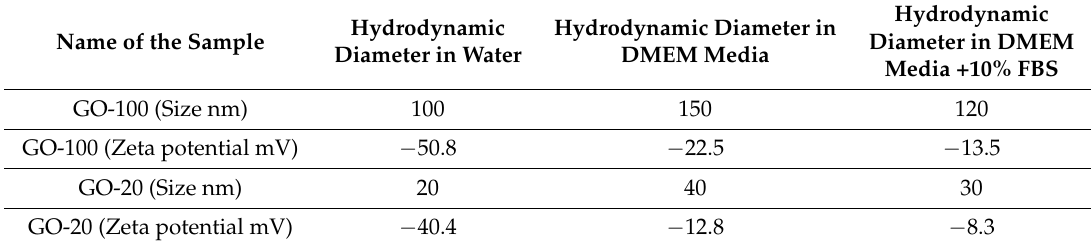
Table 1. Hydrodynamic diameter and zeta potential of GO-100 and GO-20 in different dispersion media.